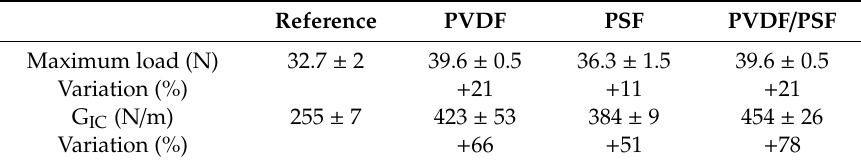
Figure 5. Mode ‐ I fracture test (DCB) outcome for reference ( a ) PSF ‐ only, ( b ) PVDF ‐ only, ( c ) PVDF/PSF Figure 5. Mode-I fracture test (DCB) outcome for reference ( a ) PSF-only, ( b ) PVDF-only, ( c ) PVDF / PSF ( d ) nanomodified samples. ( d ) nanomodified samples. Table 3. DCB test Table 3. DCB test results.